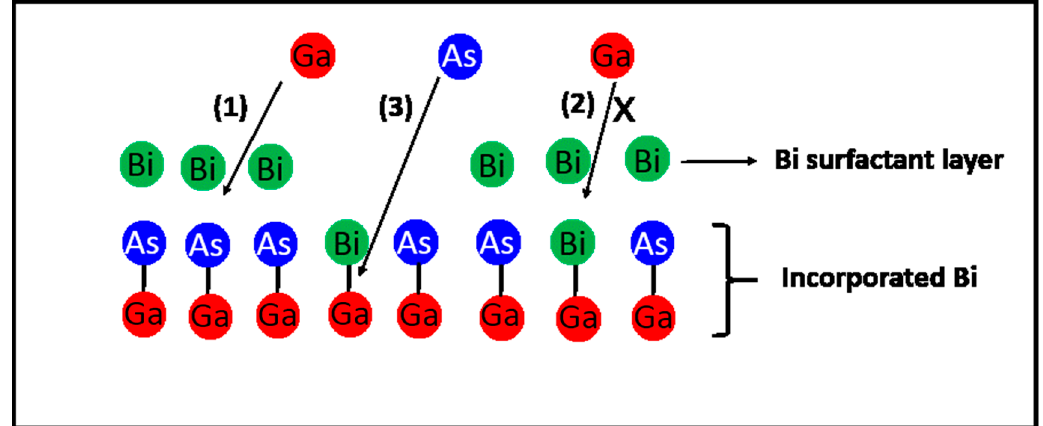
Figure 4. Schematic illustration of three processes in Lu’s GaAsBi growth model. Reproduced from Reference [122].